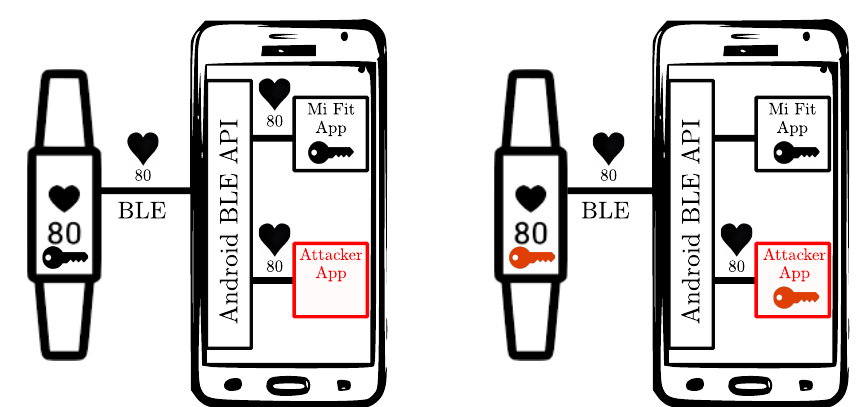
Figure 8: SB eavesdropping (left) and app impersonation (right) attacks. On the left, the attacker eavesdrops on all data exchanged by the tracker and the app by querying the tracker’s BLE GATT server without knowing the pairing key (black key). On the right, the attacker impersonates the app by re-pairing with the tracker and establishing a new pairing key (red key) unknown to the impersonated app. SB eavesdropping and app impersonation on Pairing v1 require only BLUETOOTH and INTERNET Android permissions. SB app impersonation on Pairing v2 also requires BLUETOOTH_ADMIN and